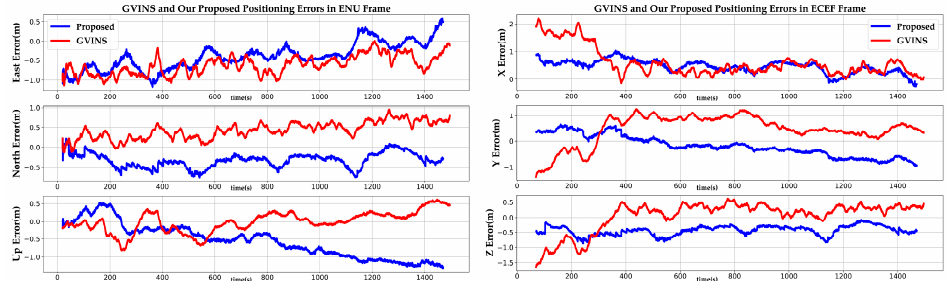
Figure 6. The positioning errors of GVINS and our proposed system in the sports field. The left three rows are the positioning errors in the east, north, and up directions of the ENU frame. The right three rows are the positioning errors in the X, Y, and Z directions of the ECEF frame. Table 1. RMSE[m] and SEP[m] statistic of GVINS and our proposed method in the sports field.